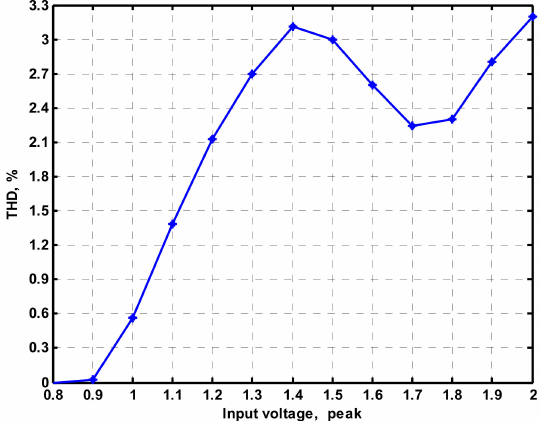
Figure 15. Dependence of output harmonic distortion of the IBP filter on an input signal